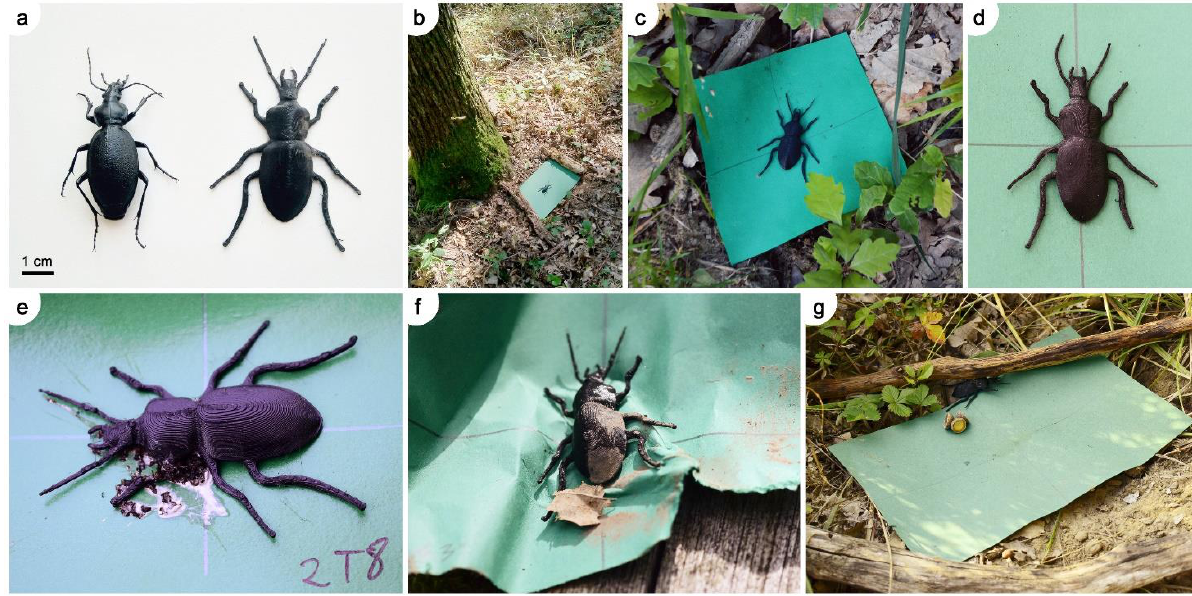
Figure 1. Printed decoy of Carabus coriaceus in comparison with a real specimen ( a ). Decoys installed on the green cardboard ( b ) were checked for turns ( c ), broken or bent parts ( d ), predation attempts by birds ( e ), wild boars ( f ) or relocations ( g ).